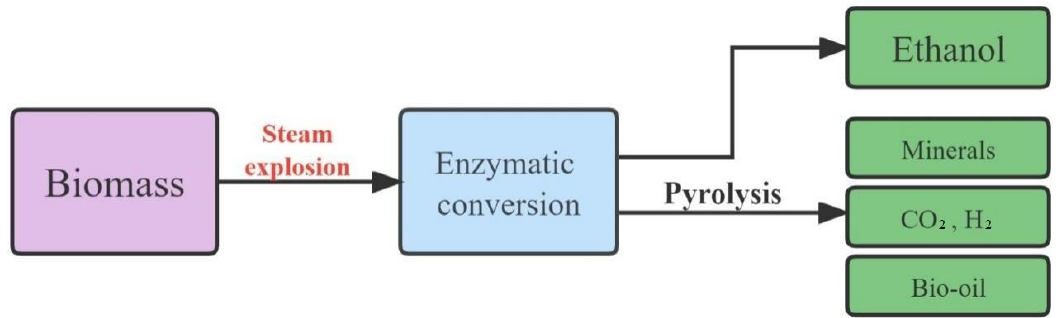
Figure 4. Steam explosion coupling bioconversion process for continuous production of ethanol and